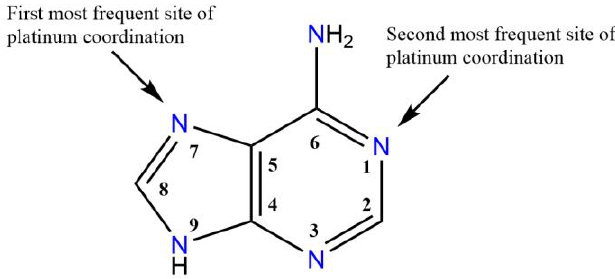
Figure 7. Structural formula of adenine, with the preferred coordination sites of platinum to nitrogen evidenced. The atom numbering scheme, for nucleotides, is also reported.